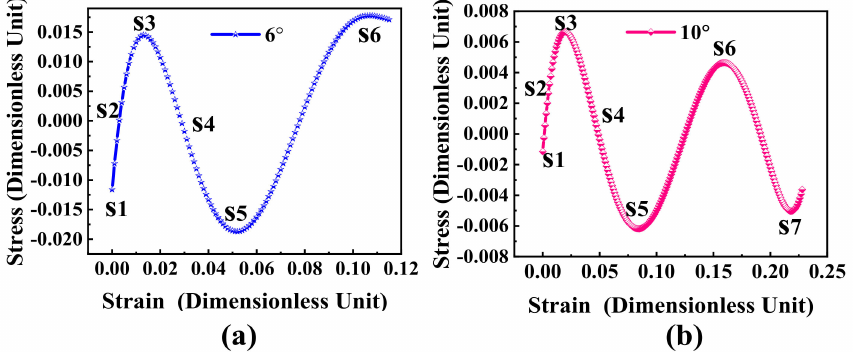
Figure 11. ( a , b ) are, respectively, the stress–strain curves at 6 ◦ and 10 ◦ from the PFC simulation. S1–S7 represent different stress value